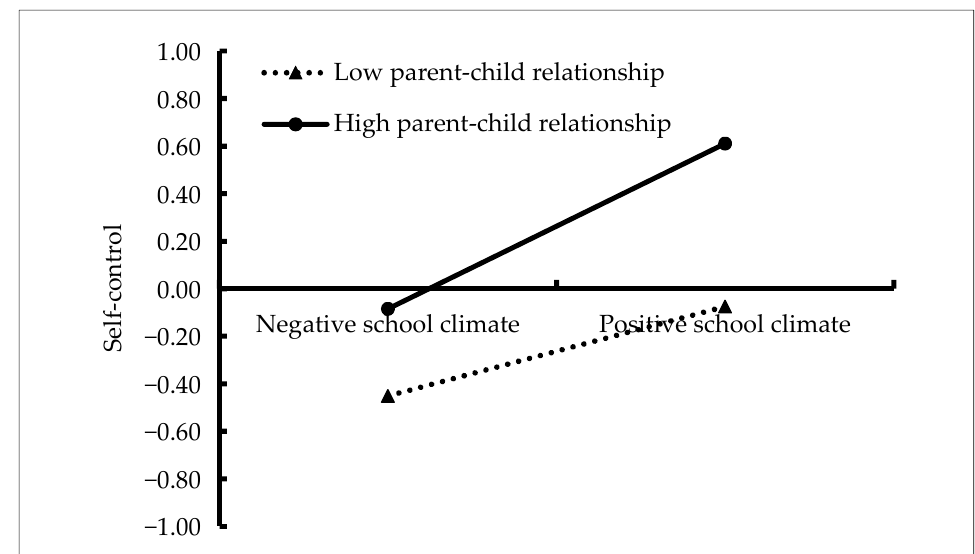
Figure 4. Self-control as a function of school climate and parent-child relationship. Finally, the bias-corrected percentile bootstrap results indicated that the indirect link between school climate and aggression via self-control was stronger for children and ad- olescents with high parent-child relationships (indirect effect = −0.08, SE = 0.03, 95% CI [−0.15, −0.03]) than for those with low parent-child relationships (indirect effect = −0.02, SE = 0.01, 95% CI [−0.05, −0.002]). Therefore, the mediating effect of self-control between